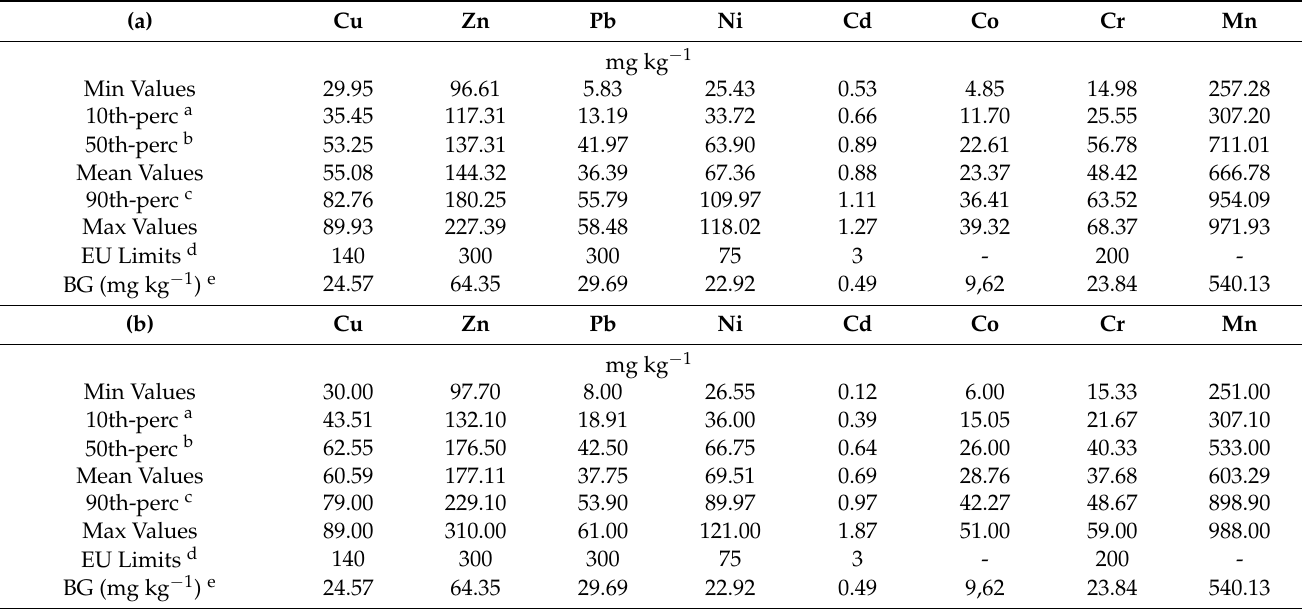
Table 2. (a): Pseudo-total concentrations of heavy metals before the COVID-19 pandemic (mean values for the four years of the study, n = 248). (b): Pseudo-total concentrations of heavy metals elements during the COVID-19